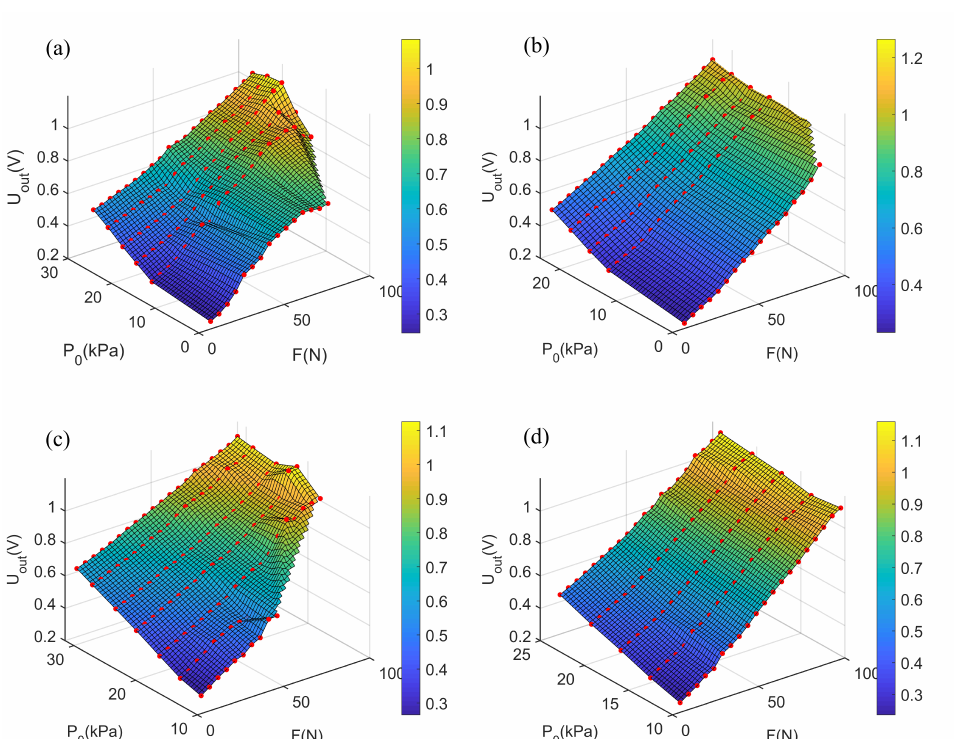
Figure 7. Visualization of the characteristics of different chambers. ( a ) Type-A chamber, with TPU thicknesses of 0.6 mm. ( b ) Type-B chamber, with TPU thicknesses of 0.6 mm. ( c ) Type-A chamber, with TPU thicknesses of 1.0 mm. ( d ) Type-B chamber, with TPU thicknesses of 1.0